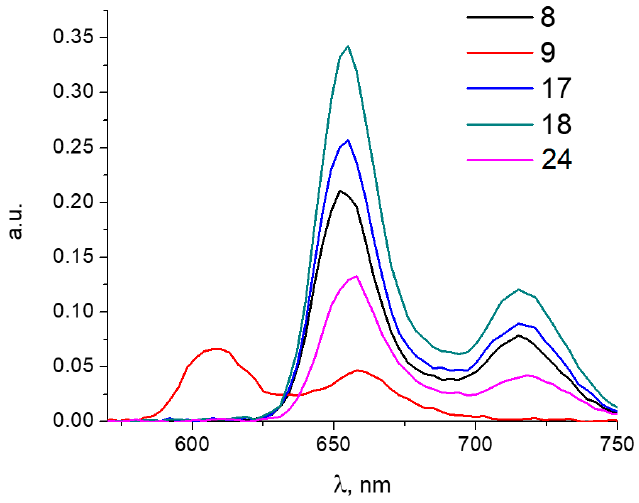
Figure 2. Fluorescence spectra of compounds 8 , 9 , 17 , 18 and 24 in